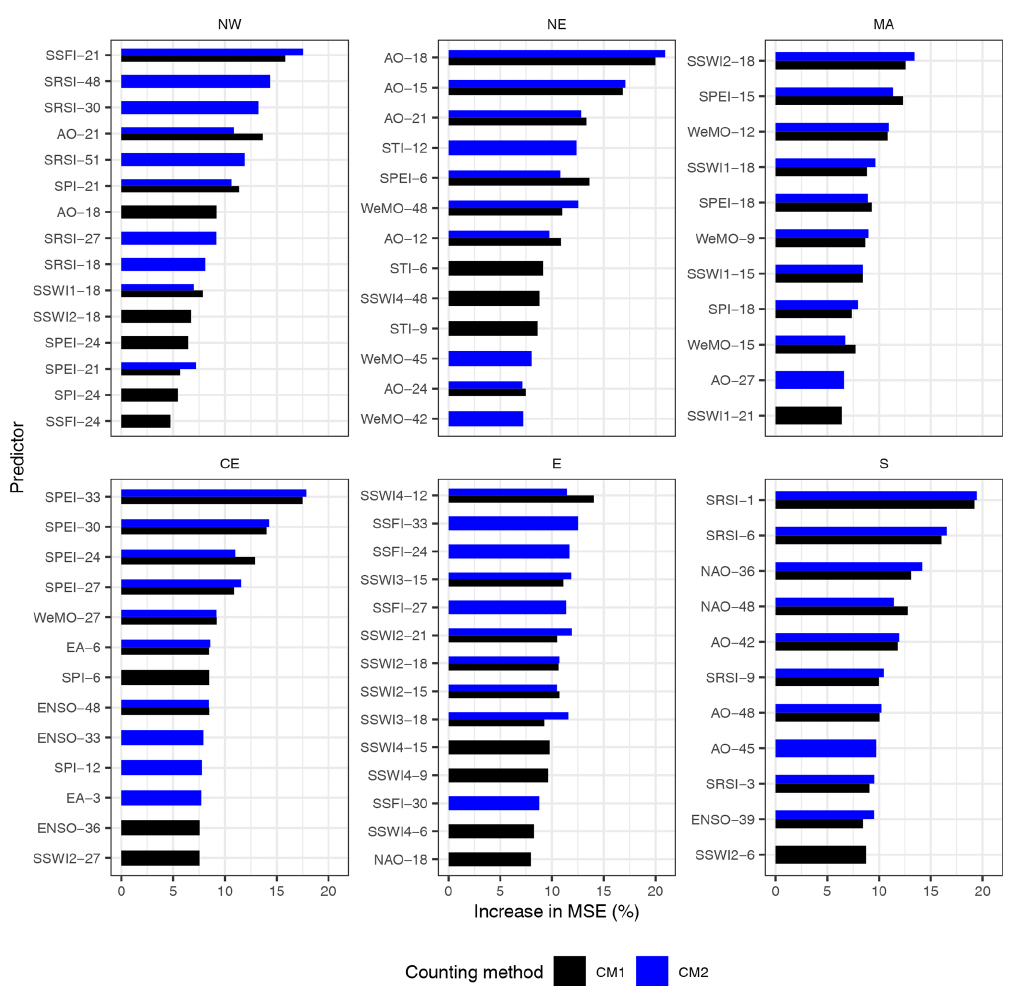
Figure 9. Predictor importance when using the regression random forest models and the two most censoring counting methods. The top 10 predictors for each counting method and sub-region are